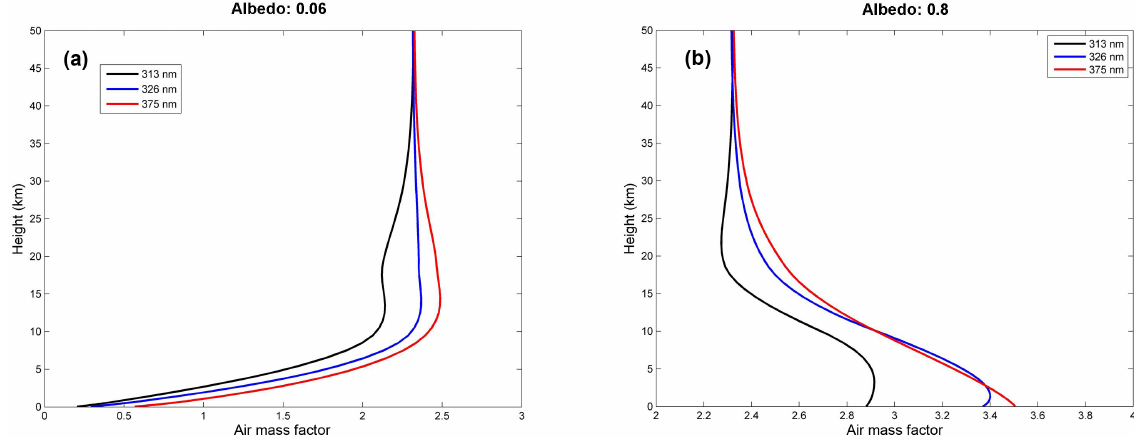
Figure 5. SO 2 box AMFs at 313, 326 and 375nm for albedo of (a) 0.06 and (b) 0.8. SZA: 40 ◦ ; LOS: 10 ◦ ; RAA: 0 ◦ ; surface height: 0km.